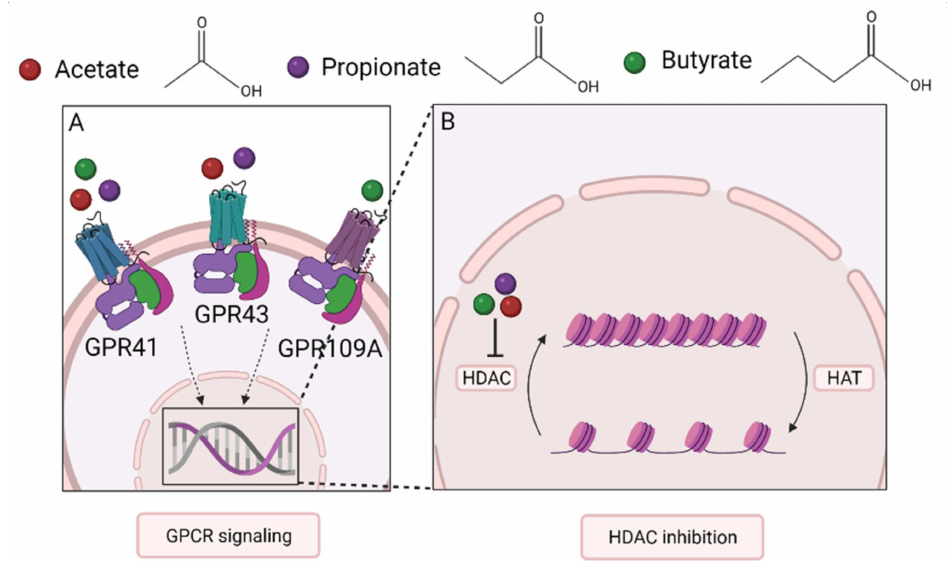
Figure 2. Mechanisms of action of SCFA. At present two mechanisms are recognized by which SCFA influence immune function. ( A ) SCFAs bind to transmembrane GPCRs on epithelial and immune cells to induce downstream signaling. GPR41 is bound by all three SCFAs, GPR43 mainly by acetate and propionate, and GPR109A mainly by butyrate. ( B ) SCFAs are also known to inhibit the enzyme HDAC. HDAC deacetylates histones which suppresses gene expression. HAT has the opposite effect. SCFA, short-chain fatty acid; GPCR, G-protein coupled receptor; HDAC, histone deacetylase; HAT, histone